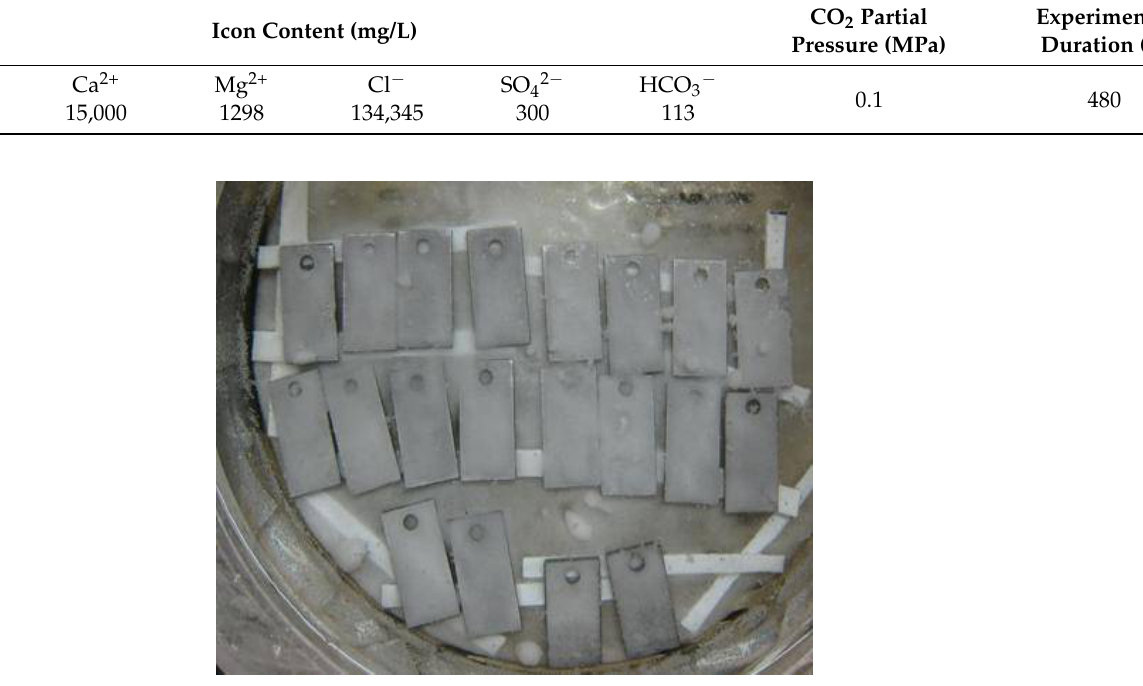
Figure 5. Metal coupon soaked in the simulated solution.